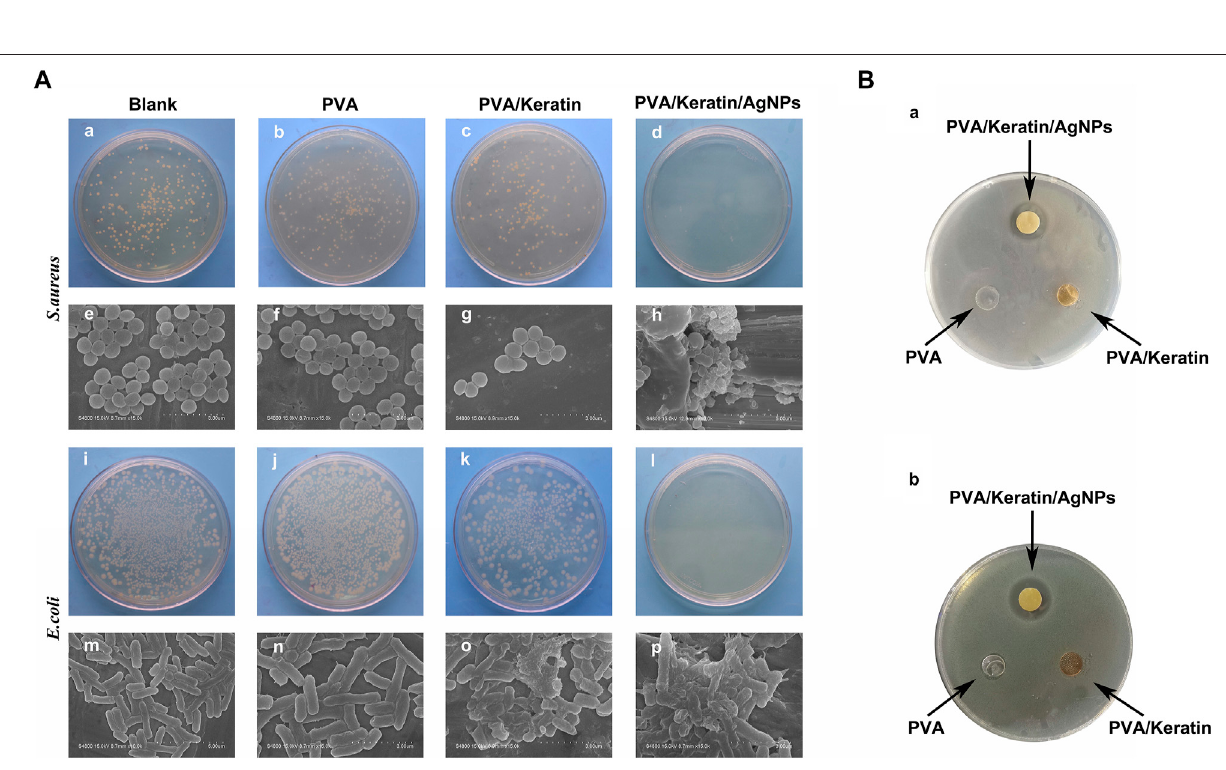
FIGURE5| ImprovedantibacterialperformanceofPVA/Keratin/AgNPs. (A) Photographsofbacterialcoloniesformedby S.aureus (a – d)and E.coli (i – l)after24 hof co-culturing with different materials, and the representative SEM images of S. aureus (e-h) and E. coli (m – p). (B) Inhibition zone of different materials to S. aureus (a) and E. coli